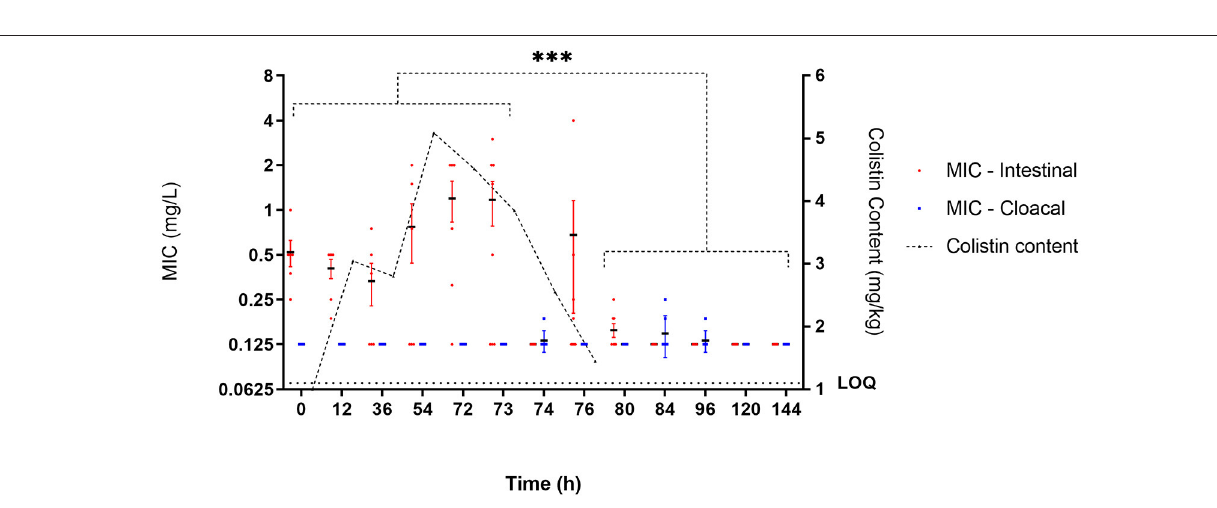
sulfate administration at 75,000 IU/kg and 3 days